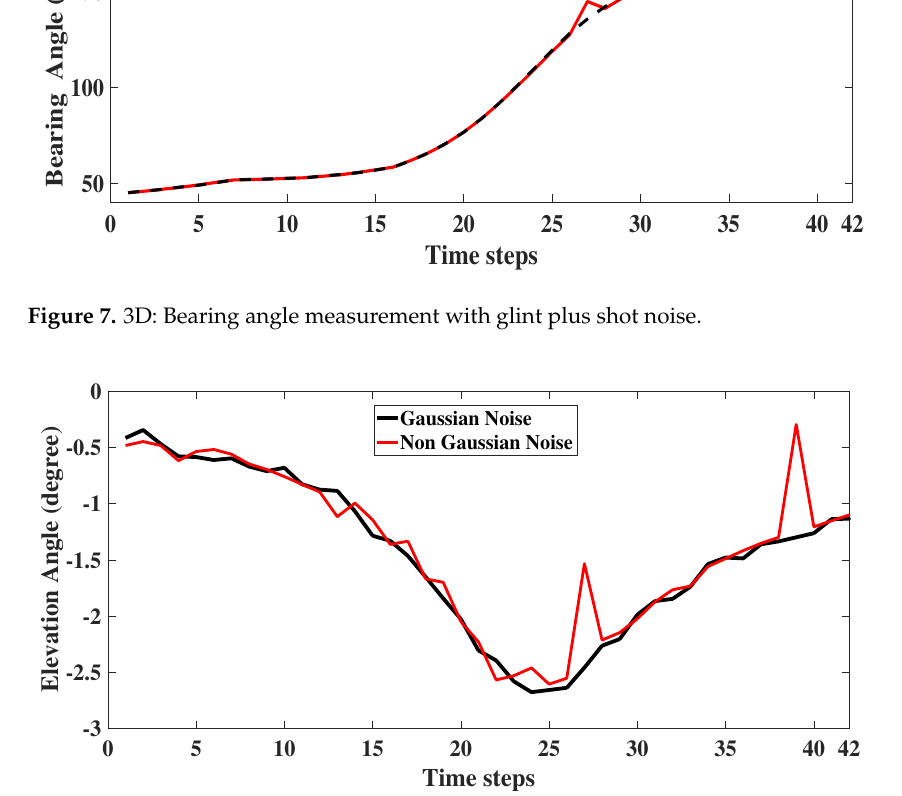
Figure 8. 3D: Elevation angle measurement with glint plus shot